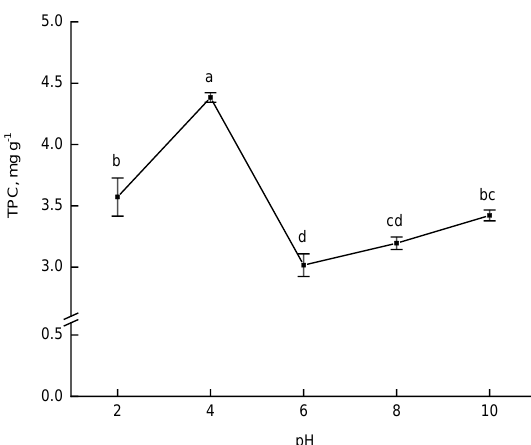
Figure A1. Effect of Tween 80 concentration in water on the extraction of phenolic compounds from apple pomace (time 60 min, solvent-to-material ratio 80 mL g −1 , pH 4). Different lower case letters indicate significant differences among treatments ( p ≤ 0.05) based on post hoc Tukey’s test.